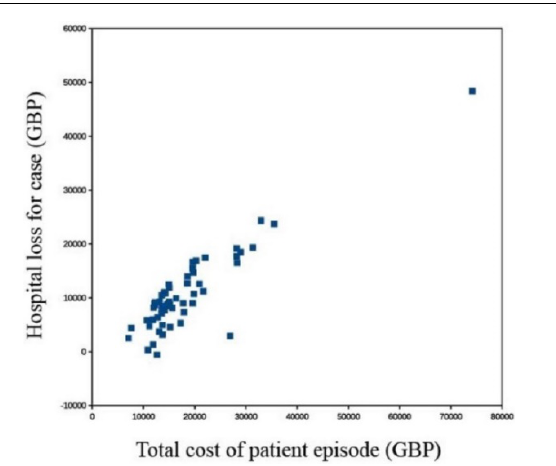
Figure 3 . Cost of patient episode compared to total loss to the hospital. Compared to total: The one patient who had a failed free flap and required another free flap is a gross outlier, it was the most expensive episode, just over £74 000 and had the highest deficit, more than £48 000. This scattergraph shows there is a correlation between the cost of an episode and the short fall in funding: more expensive episodes are more underfunded. One of the 60 episodes made a profit for the